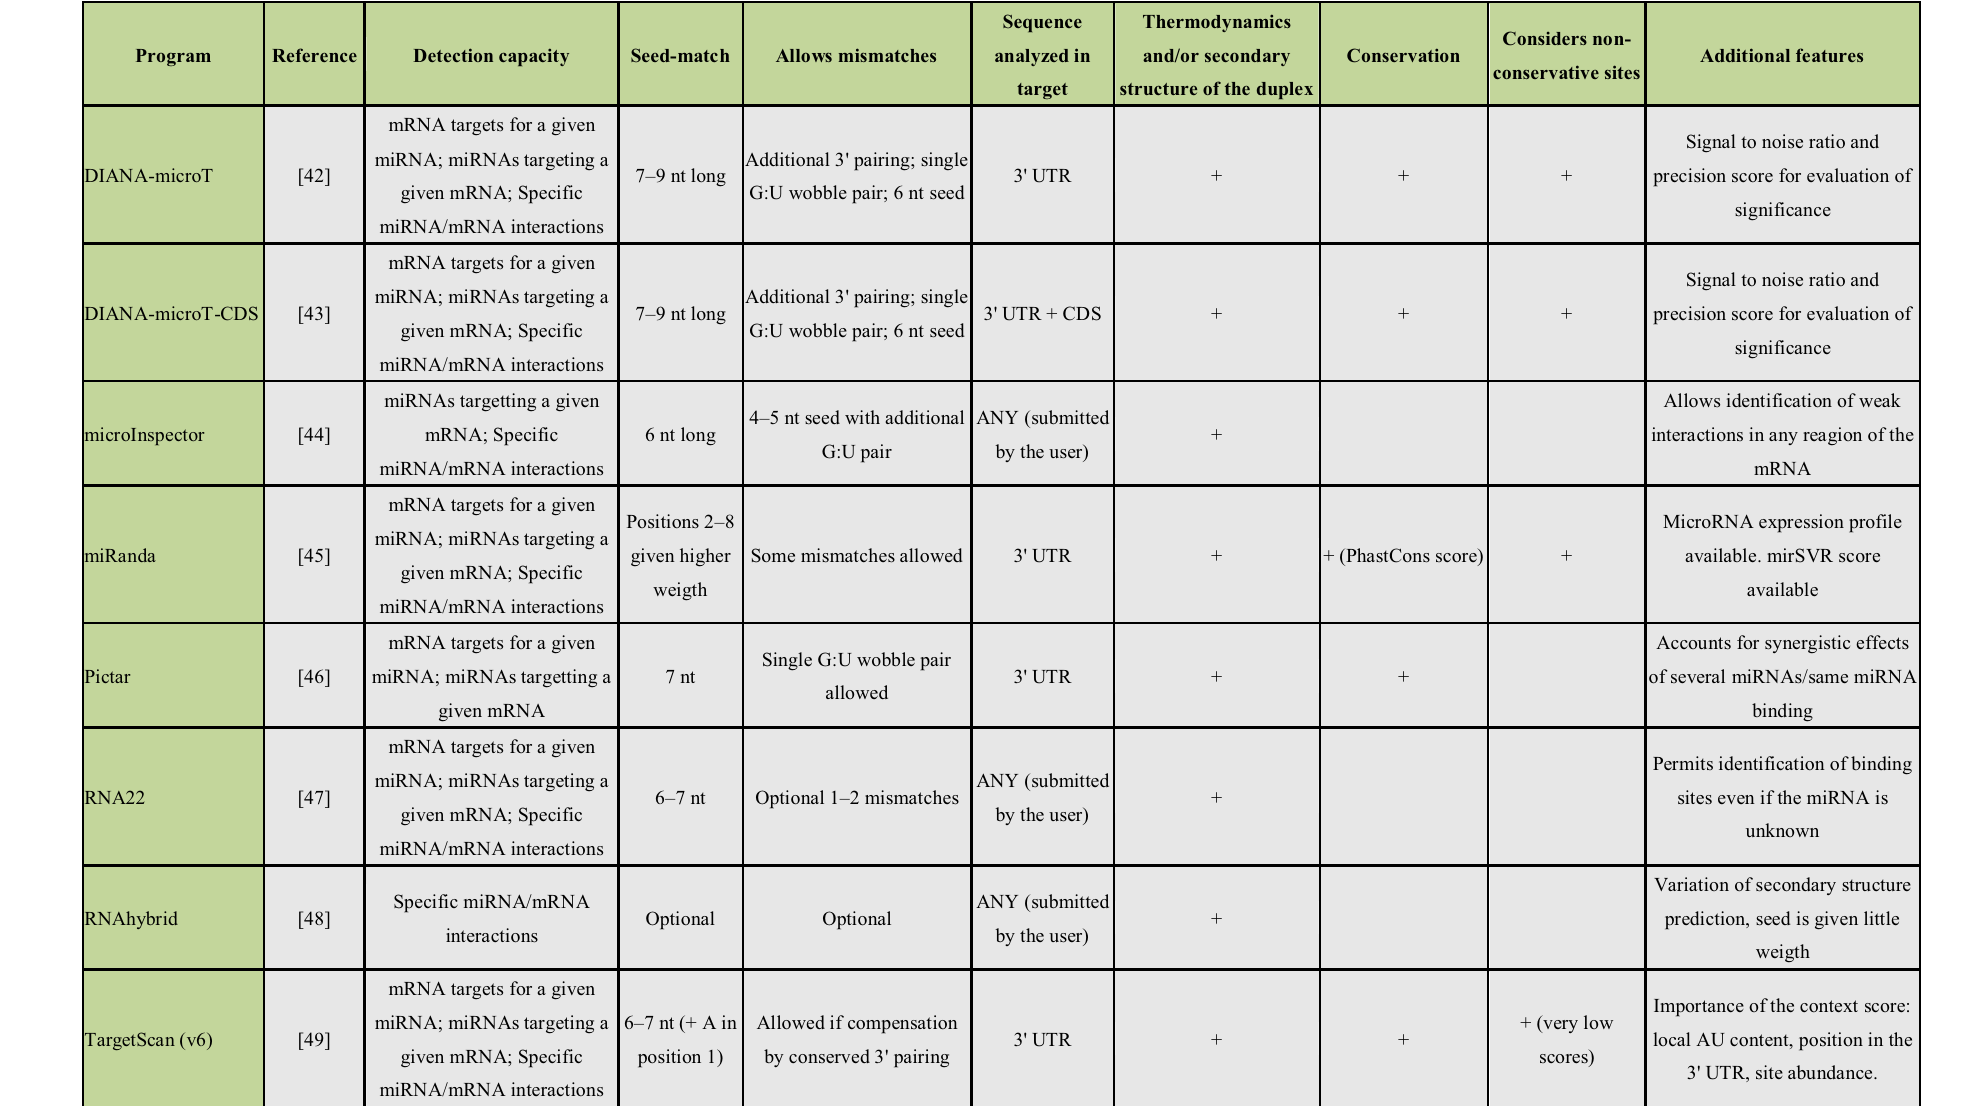
Table 1. Characteristic features of the most commonly used programs for prediction of miRNA